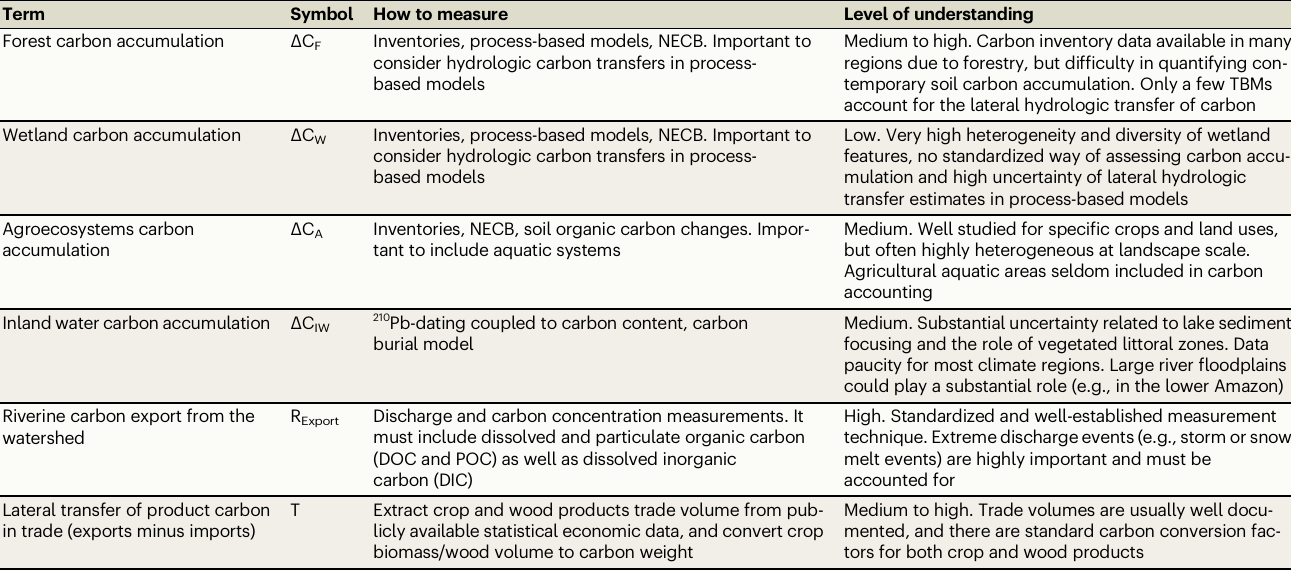
Table 1 | Elements involved in the calculation of net watershed exchange (NWE), approaches to measure them, and current level of understanding Term Symbol How to